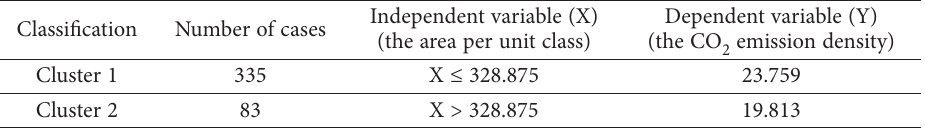
Table 2. Definition of the splitting criteria for the cluster formation